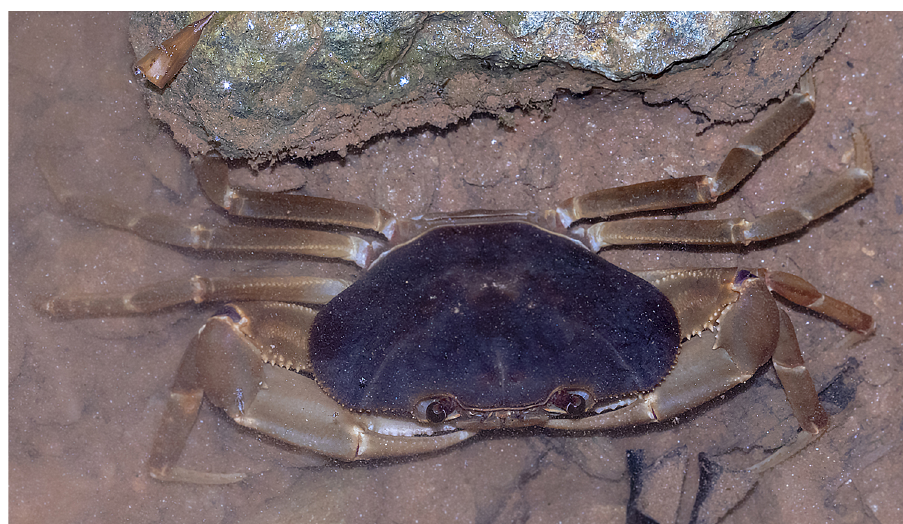
Figure 10. Adult female of Epilobocera capolongoi (CZACC 5.0045) found active at night in the tributary source of Higuanojo river on 10 November 2018. Photo by Aslam I. Castellón.